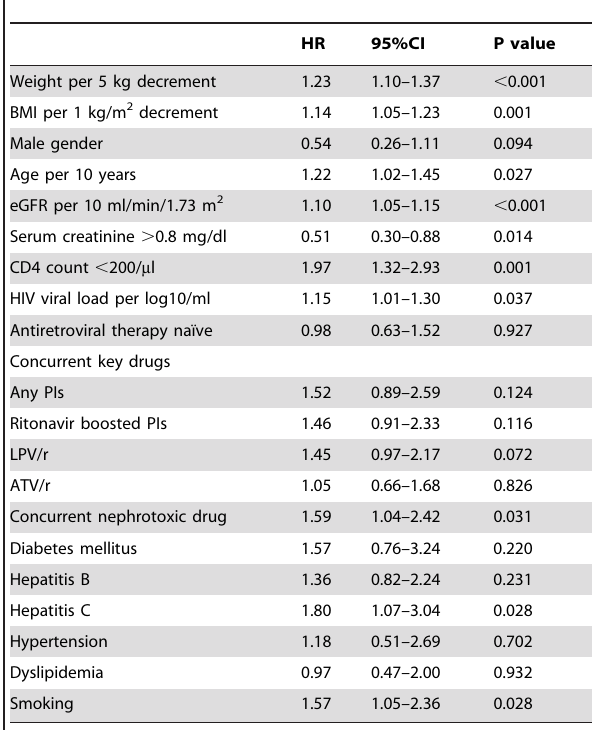
Table 2. Univariate analysis for TDF-associated renal